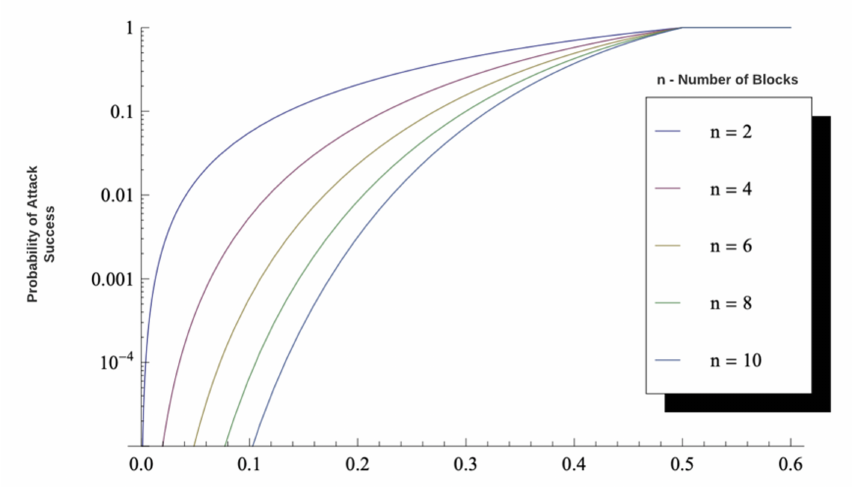
Figure 4. Analysis of hash rate-based